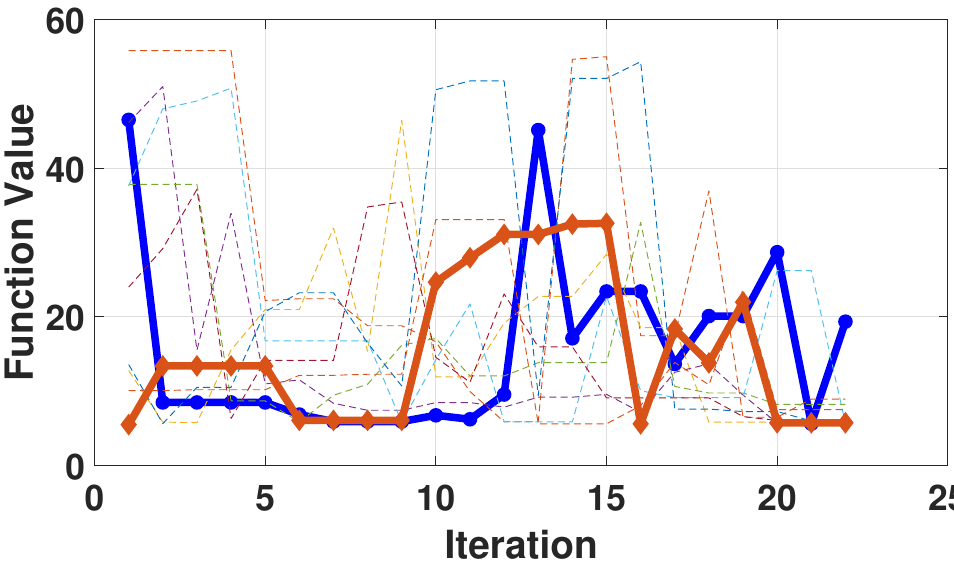
Figure 8. Iterative process of the 2D target imaging distance estimation based on simulated anneal- ing